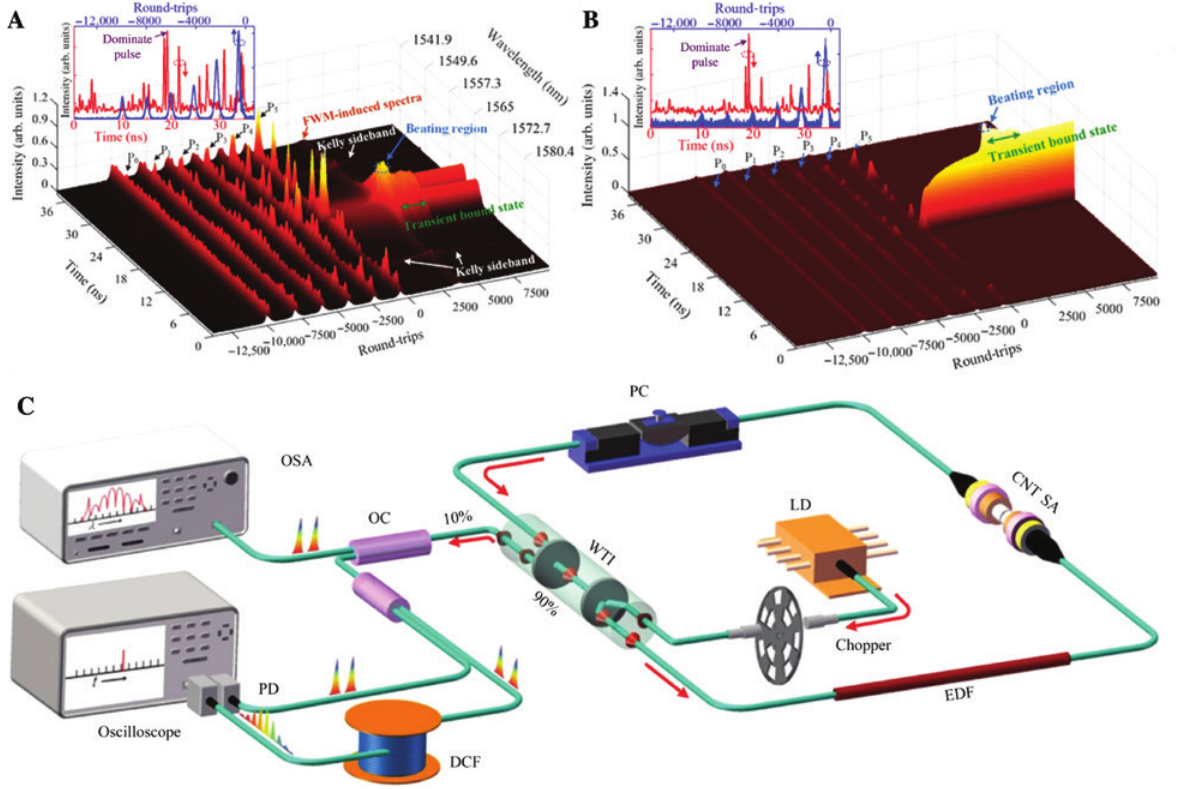
Figure 14: Experimental real-time characterization of the entire buildup process of a SM in a mode-locked laser. (A) With and (B) without the TS DFT technique, respectively. (C) The corresponding experimental setup for the mode-locking laser. Liu et al. [204]. © American Physical Society